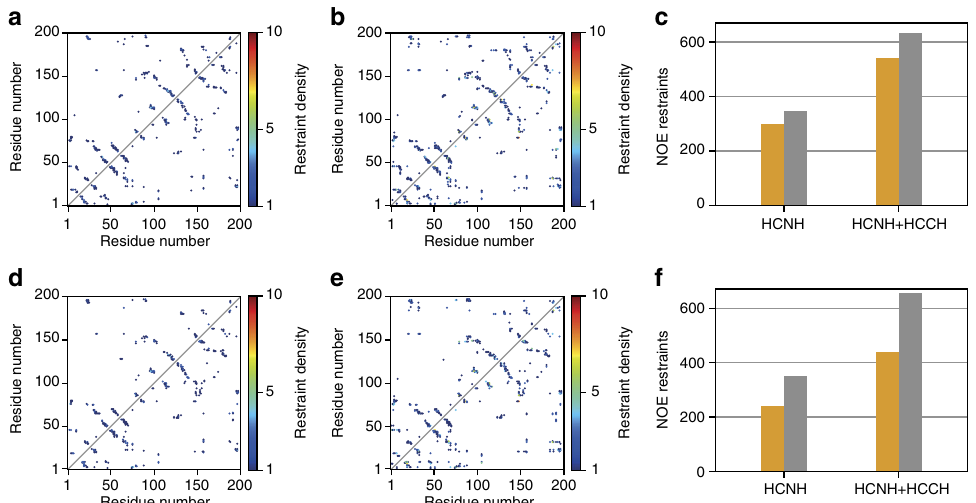
Fig. 6 Comparison of assigned NOE contacts versus predicted from X-ray structure. Contacts shown as a function of residue pairs along the sequence of α - lytic protease. Upper triangular region shows NOE contacts identi fi ed during iterative structure re fi nement by autoNOE-Rosetta, while that of lower triangular region represents expected contacts as predicted from the X-ray structure (PDB ID 1P01) using a 5.5 Å distance cutoff between all possible proton atom pairs and further removing redundancies due to chemically equivalent protons. Different combinations of input assignments and NOE datasets used are shown as follows. a Supervised assignments with HCNH NOEs. b Supervised assignments with HCNH+HCCH NOEs. c Total number of NOE restraints assigned in a and b (orange) versus predicted from X-ray structure (gray). d 4D-CHAINS TOCSY-NOESY automated assignments with HCNH NOEs. e 4D-CHAINS TOCSY – NOESY automated assignments with HCNH+HCCH NOEs. f Total number of NOE restraints assigned in d and e (orange) versus predicted from X-ray structure